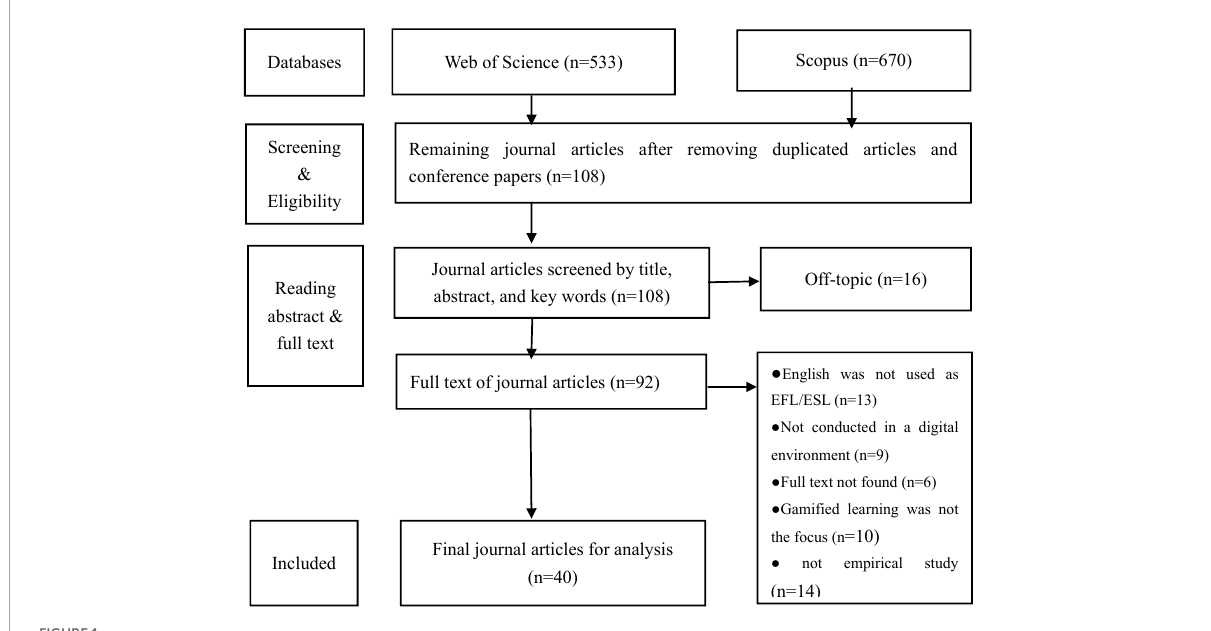
FIGURE1 Flowchart process